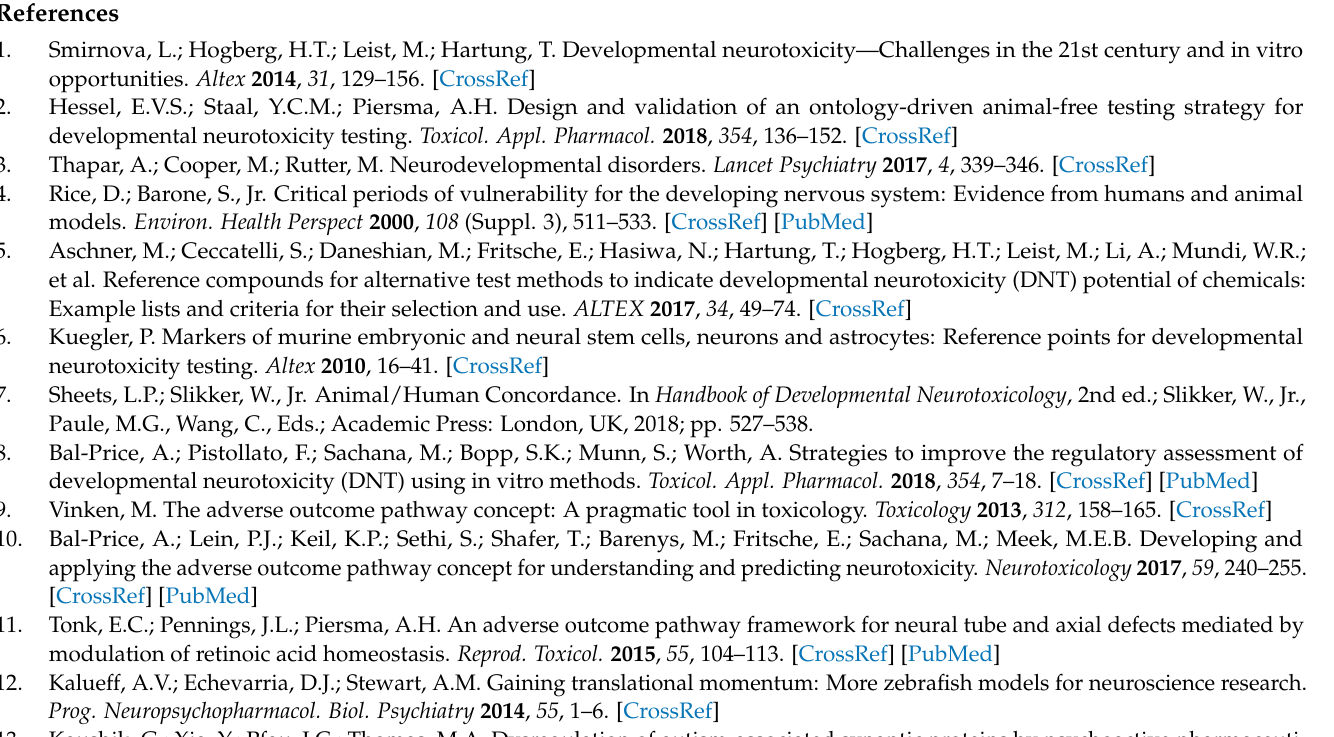
0–120-hpf exposure, Figure S3: Dose–response curves of an individual CBZ experiment, Figure S4: Fluoxetine—Plot overview showing a complete light-dark transition test applied for the FLX experi- ment, after 0–120-hpf exposure, Figure S5: Dose–response curves of an individual FLX experiment, Figure S6: Venlafaxine—Plot overview showing a complete light-dark transition test applied for the VNX experiment, Figure S7: Dose–response curves of an individual VNX experiment, Figure S8: Carbamazepine BMD confidence intervals, Figure S9: Fluoxetine BMD confidence intervals, Figure S10: Venlafaxine BMD confidence intervals, Figure S11: Phenytoin—Plot overview showing a short light-dark transition test applied for a PHT experiment (R1), after 0–120-hpf exposure, Figure S12: A dose–response curve of an individual PHT experiment (R1), Figure S13,S14,S15: Exposure windows analysis, Table S1: Test compounds and exposure dose ranges in ZFET, Table S2: Carbamazepine CEDs at 5% effect level of each dark period of the L-D transition test, Table S3: Fluoxetine CEDs at 5% effect level of each dark period of the L-D transition test, Table S4: Venlafaxine CEDs at 5% effect level of each dark period of the L-D transition test, Table S5: Overview single-compound DR